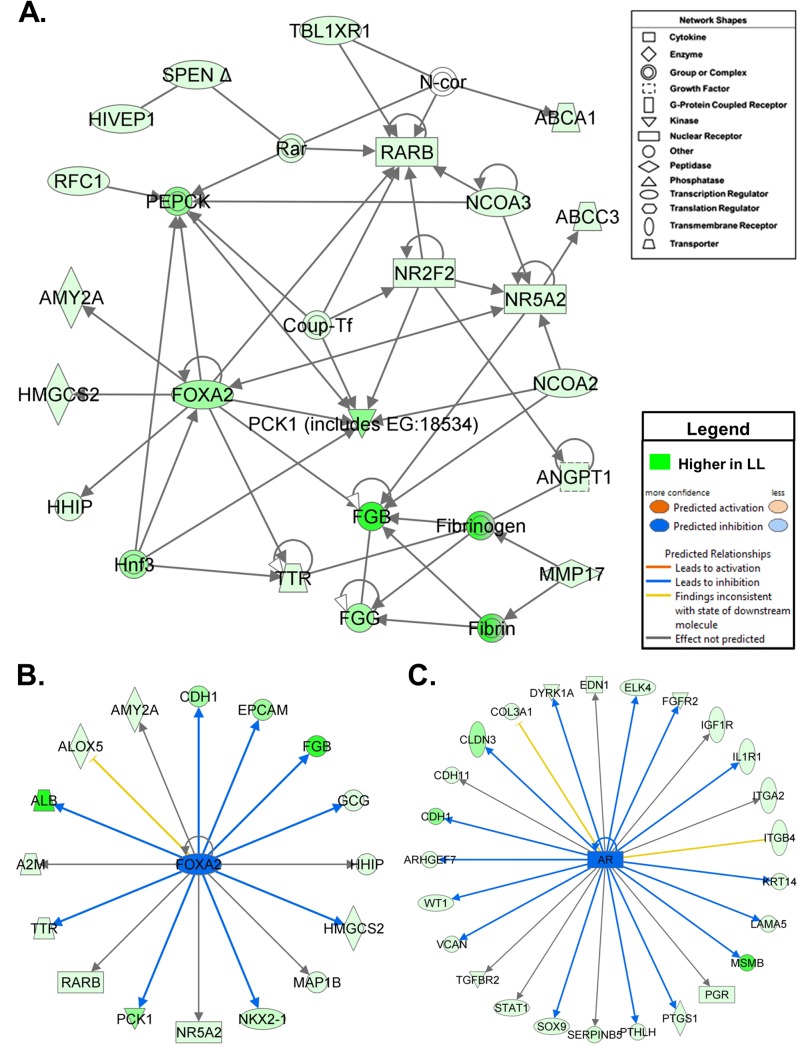
Gene interaction network of up-regulated genes and direct targets of up-regulated transcription factors in abdominal fat of the LL chickens.(A) This direct gene interaction network of up-regulated DE genes in the LL chickens was identified by IPA as “Developmental Disorder, Hematological Disease, or Hereditary Disorder”. (B) The Ingenuity Upstream Regulator Analysis predicts inhibition of forkhead box A2 (FOXA2; blue-colored symbol with a z-score of -2.52), since 9 of its 17 direct targets have down-regulated expression ratios (FL/LL), which is consistent with inhibition of FOXA2 (i.e., down-regulated in FL or up-regulated in LL). (C) Likewise, the predicted inhibition of the androgen receptor (AR; blue-colored symbol with a z-score of -3.04) would lead to inhibition (blue arrows) of its direct targets, since 15 of 27 genes are inhibited in the FL (i.e., a reduced FL/LL ratio or up-regulated in the LL). According to RNA-Seq analysis, the expression of both FOXA2 (fold-change of -10.7) and AR (fold-change of -1.4) was higher in the LL.